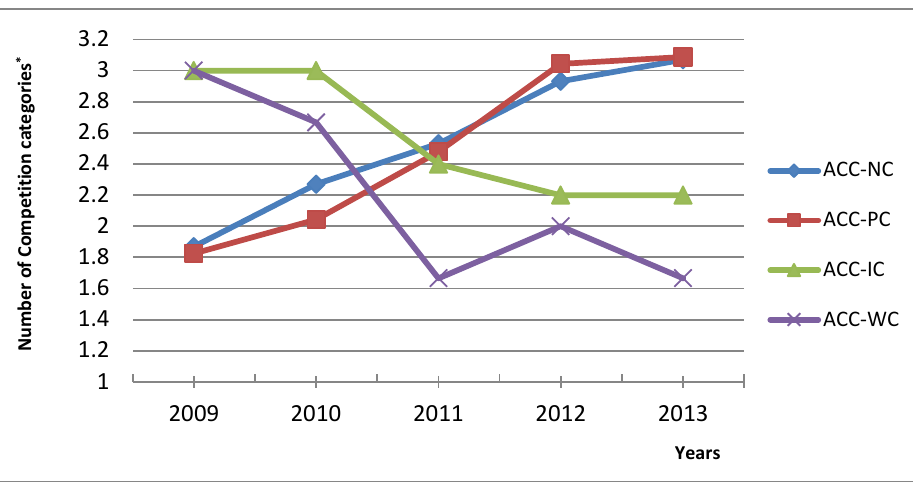
Figure 3. Display of competitions in higher age categories besides judokas primary age category. * 1 = Primary age category; 1 < number of higher age categories. ACC—average number of competitions categories; NC—National class; PC—Perspective class; IC-International Class; WC— World class.